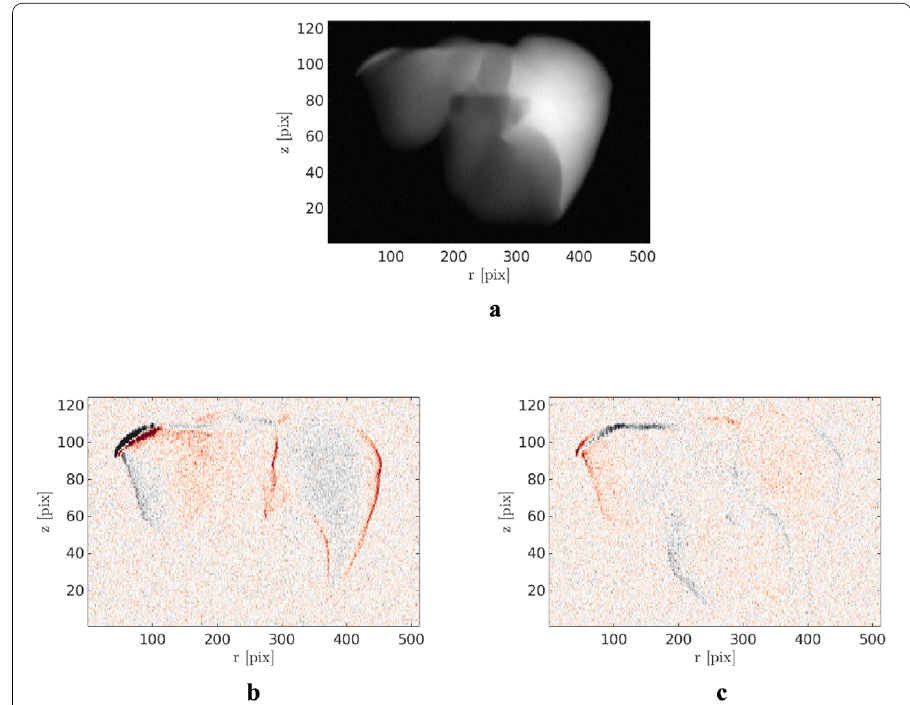
Fig. 4 a Projection of the liver at angle 8 π/ 5 and b , c two initial projections corresponding to two different vibration states. The ground truth amplitudes for mode 1–2–3 are respectively for b and c [0.40; 0.76; − 0.19] and [0.32; − 0.20; − 0.23]. Note that projections are shown with the acquisition scale factor [0.56,